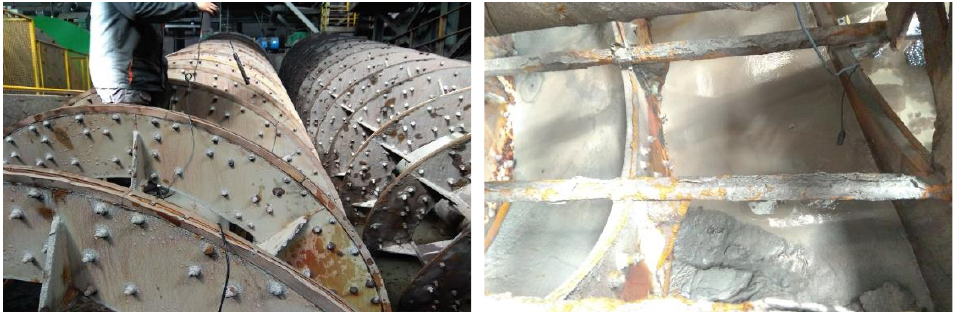
Figure 3. Spiral classifier potential measurements during the trial cathodic polarization.